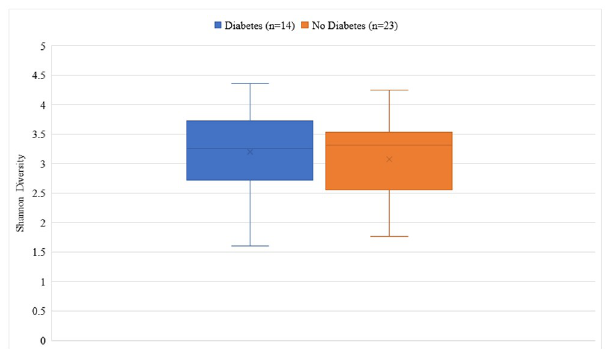
Fig 1. Shannon diversity by diabetes status.